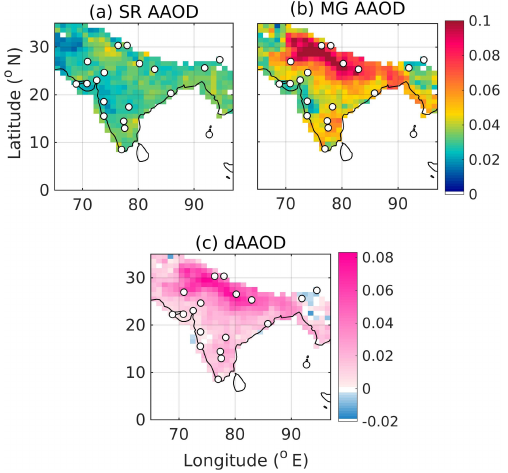
Figure 9. Spatial variation of monthly mean SR AAOD (a) , MG AAOD (b) and dAAOD (c) for May